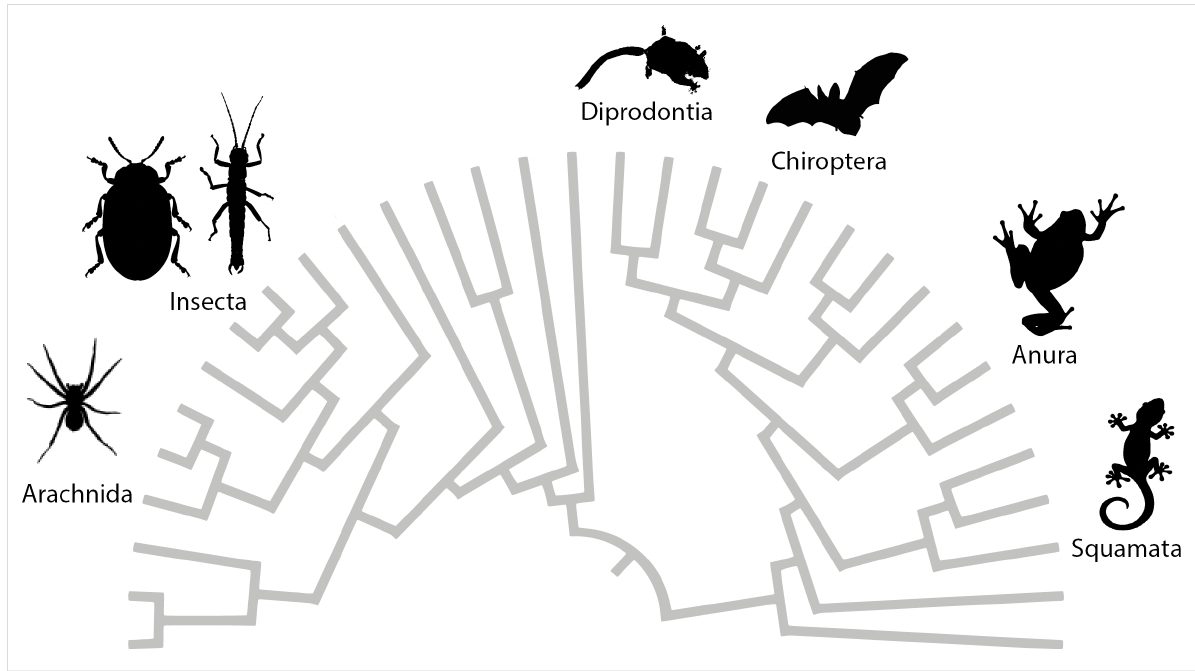
Figure 1: Diversity of investigated study organisms with attachment devices visualised across the animal tree of life. Attachment devices are almost omnipresent in